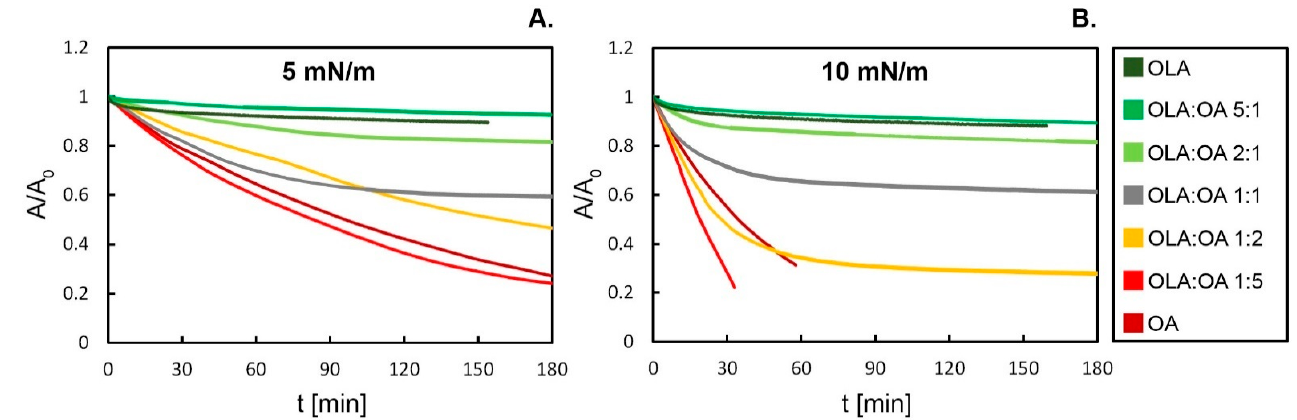
Figure 4. The relative area changes during the relaxation experiment for single substance monolayers (OLA and OA), as well as for binary monolayers for various mole fractions at 5 mN/m ( A ) and 10 mN/m ( B ). In general, mixed OLA:OA systems are characterized by the intermediate stability between the extremely different monolayers of pure substances. However, a system with a small addition of OA to OLA is more stable than OLA itself, and a system with a small addition of OLA to OA degrades even faster than a pure OA